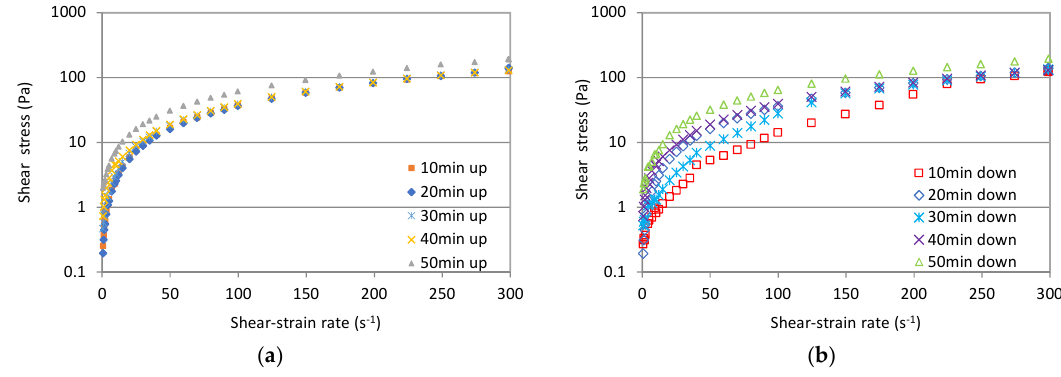
Figure 2. Shear stress curves of the reference grout: ( a ) up curve, ( b ) down curve.